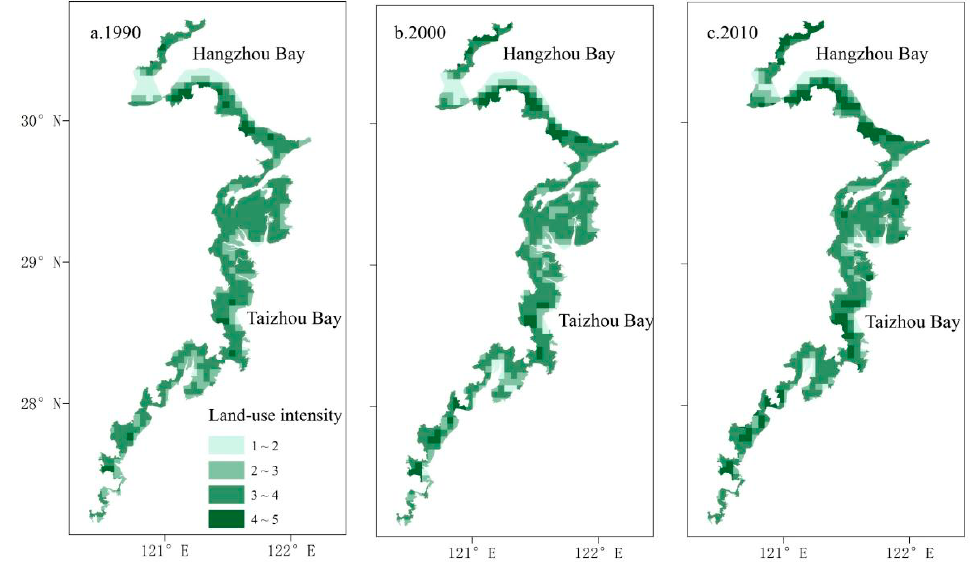
Figure 4. The distribution of land-use intensity for the years 1990, 2000, and 2010. ( a ) the distribution of land-use intensity for the year 1990; ( b ) the distribution of land-use intensity for the year 2000; ( c ) the distribution of land-use intensity for the year 2010.